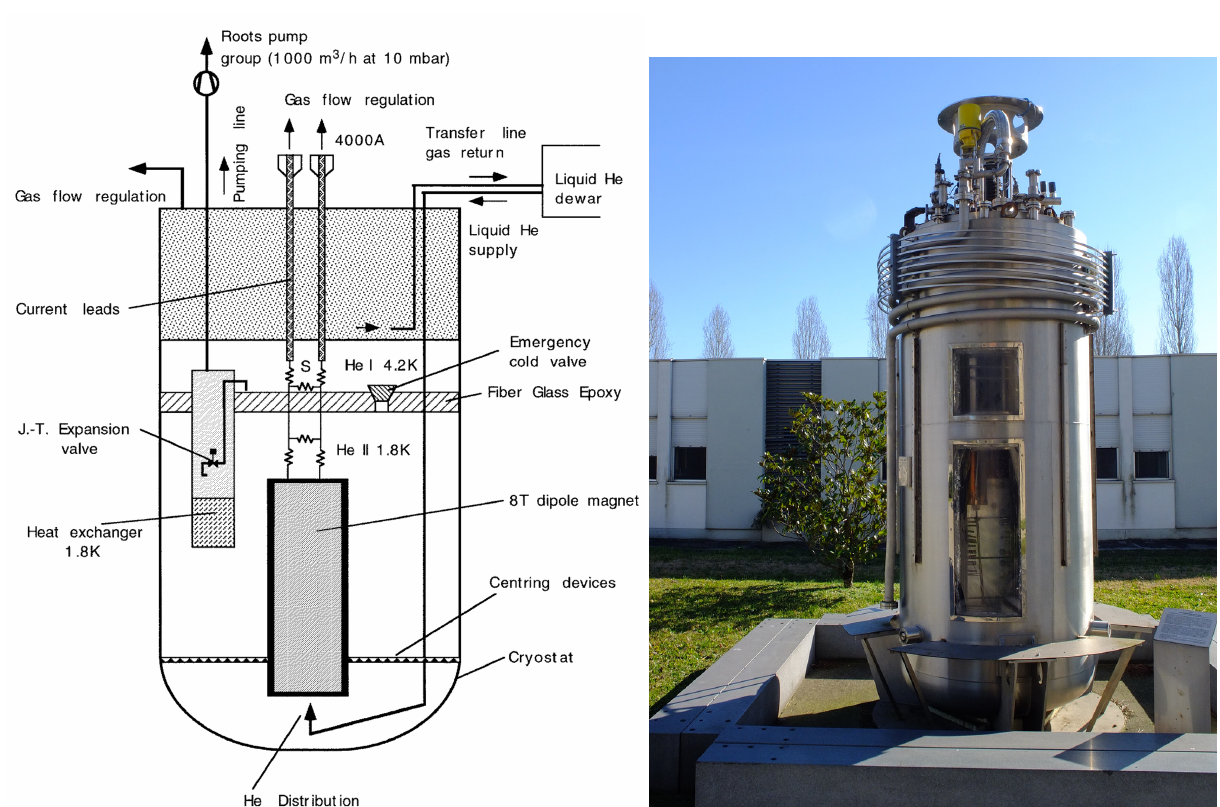
Figure 9. ( Left ) Scheme of the rotating cryostat of the PVLAS-LNL experiment designed to cool the dipole magnet to superfluid helium. A 30.5 mm warm bore (not shown) vertically traversed the cryostat. Source: From Ref. [83], (© IOP Publishing. Reproduced with permission. All rights reserved). ( Right ) Photograph of the cryostat of the PVLAS-LNL experiment. The cryostat is exhibited on the INFN National Laboratories of Legnaro (LNL) site near Padua, Italy. In the cutaway the prototype CERN magnet can be